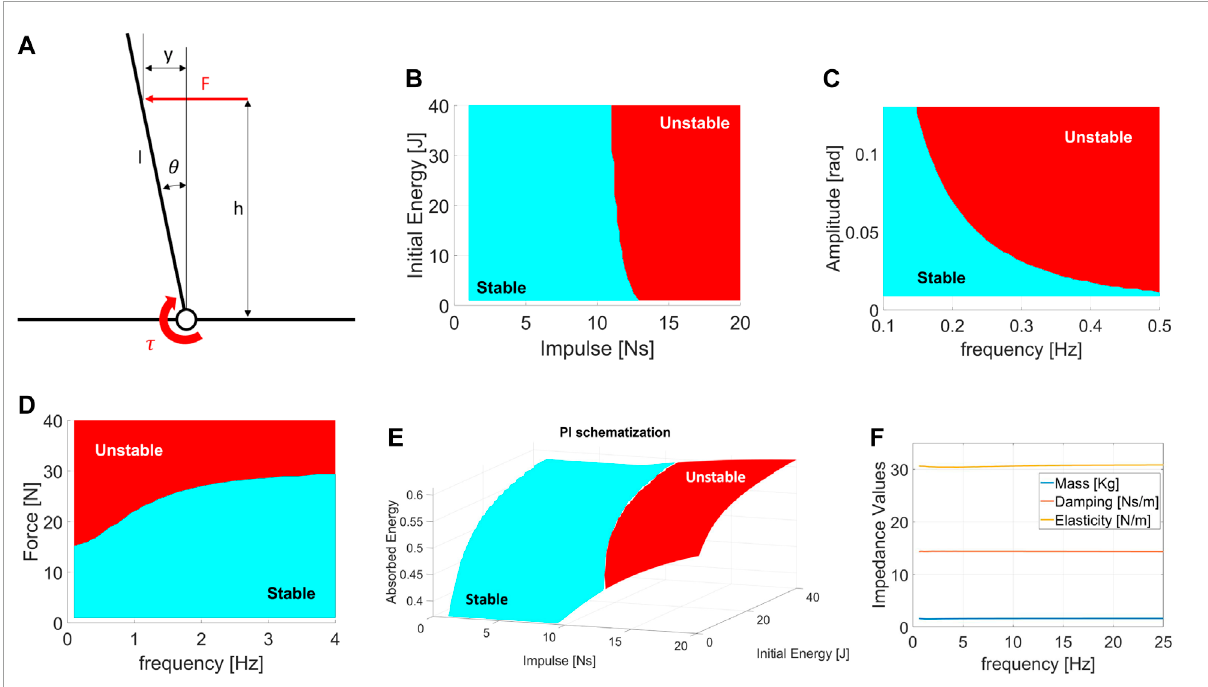
FIGURE 2 (A) Schematized Model used to visualize the Performance Indicators results. Example of: (B) Impulsive resilience chart. (C,D) Excited Resilience charts, where (B) is the ERrelated to a displacement perturbation, while (C) is the ERrelated to an oscillating force. (E) Absorbed Energy chart during Impacts. (F) Excited Equivalent Impedance chart. All picture refers to the model in (A) . The region of conditions at which the robot shows unstable behavior is reported in